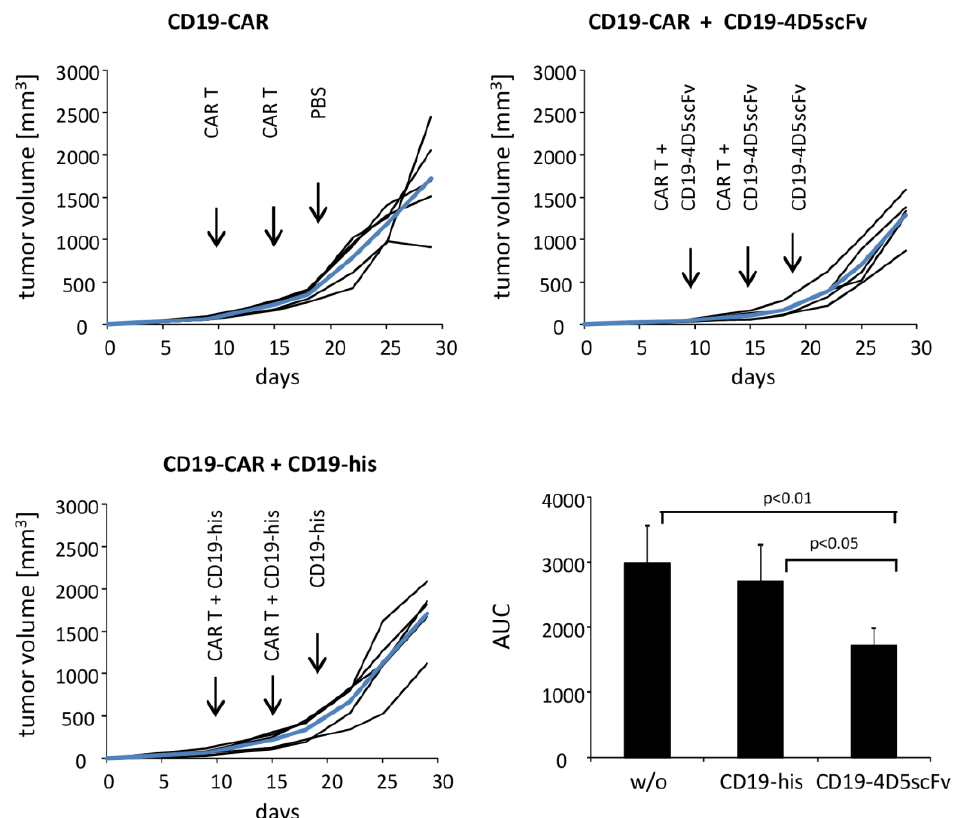
Figure 5. CD19-4D5scFv redirected CD19-CAR T cells suppressed the growth of the ErbB2 + SKOV-3 tumors. Rag2 − / − c γ − / − mice (five mice/group) were subcutaneously inoculated with the ErbB2 + SKOV-3 tumor cells (5 × 10 6 cells/mouse). Mice with established tumors were i.v. treated with the CD19-CAR T cells on day 9 (3 × 10 5 cells/mouse) and day 15 (5 × 10 5 cells/mouse). Fusion protein CD19-4D5scFv or CD19-his (each 200 µ g/mouse) were co-injected, as indicated; on day 18 fusion protein without CAR T cells was injected, PBS served as the control. Tumor growth was recorded and the tumor volumes were determined (mean values: bold blue lines). Areas under curves (AUC) were calculated, mean values were determined, and significant differences were determined by Student’s t test.